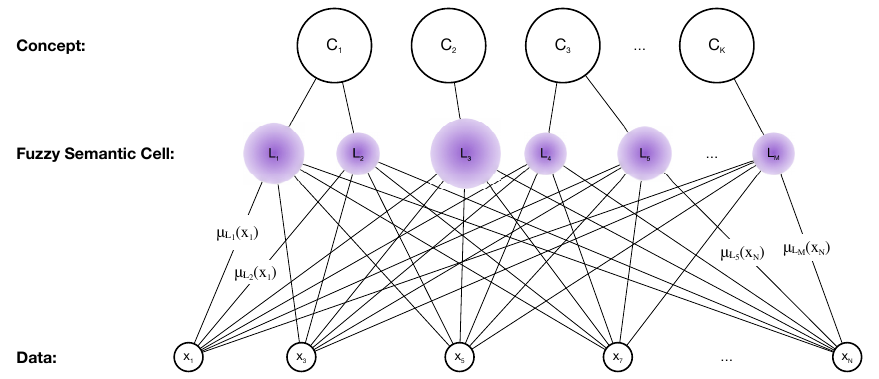
Figure 2. The hierarchical structure diagram of concept learning